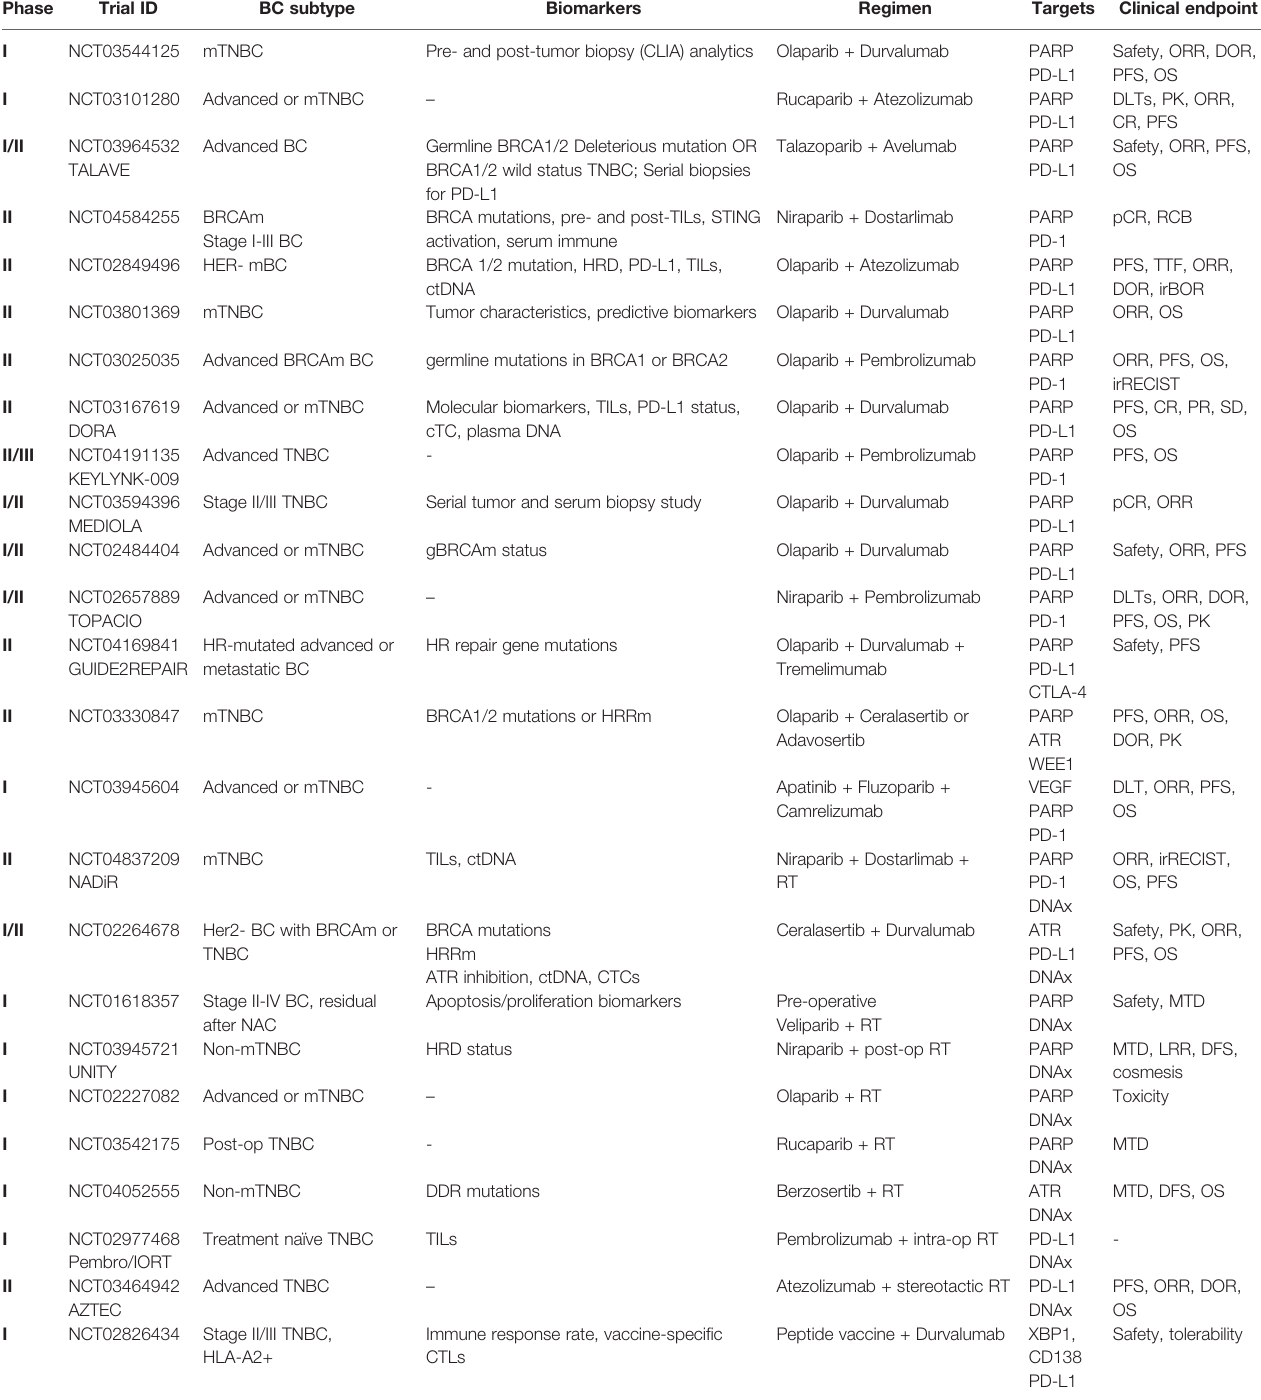
TABLE 1 | Ongoing clinical trials of combination DNA targeting and/or immunotherapy agents in TNBC or BC with DDR mutations.